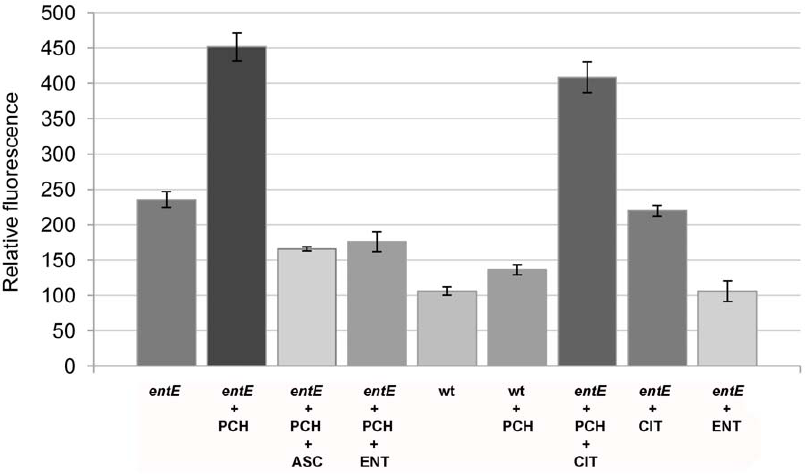
Figure 2. Levels of reactive oxygen species in E.coli wild type and entE mutant. Quantitation of ROS levels using the DCFA-DA probe. Fluorescence intensities are relative to that of the control. Control: wt grown in 2 mL M9 medium; PCH indicates cells grown in the presence of 15 m M pyochelin; ASC indicates supplementation with 1 mM ascorbic acid; ENT designates addition of 1 m M of pure enterobactin; CIT indicates supplementation with 50 m M citrate. Error bars=SEM, n=3.